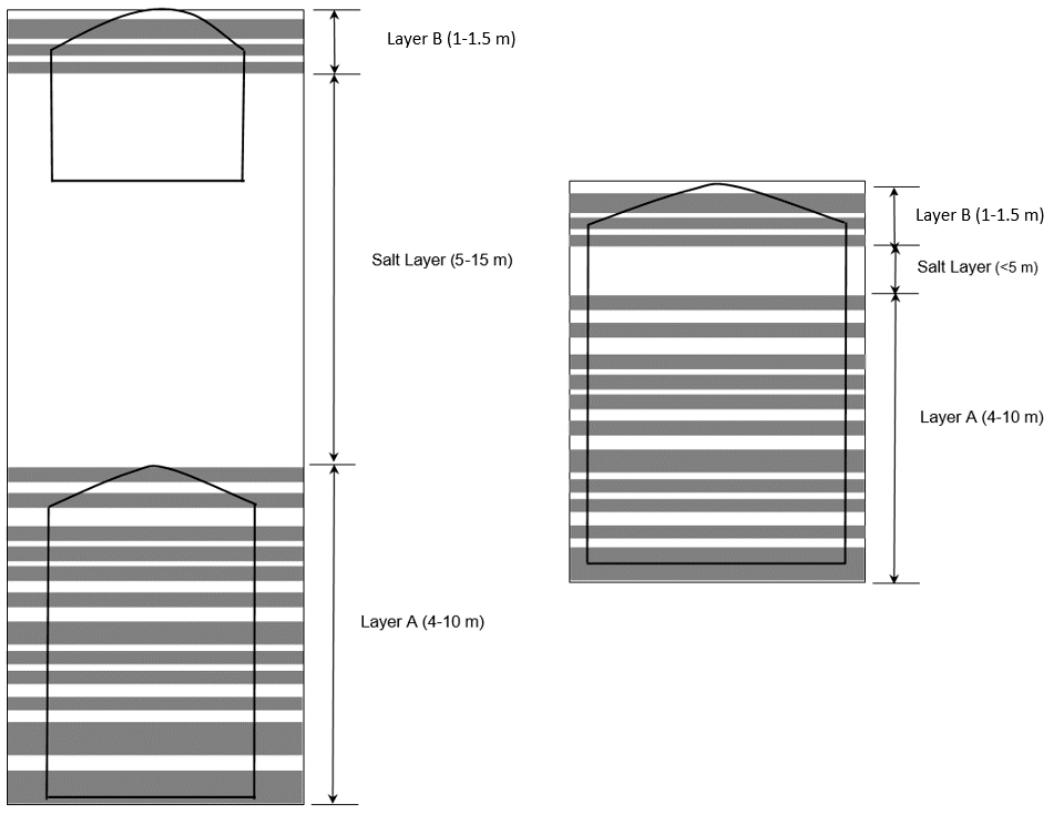
Figure 1. Seams layout and exploitation alternatives.